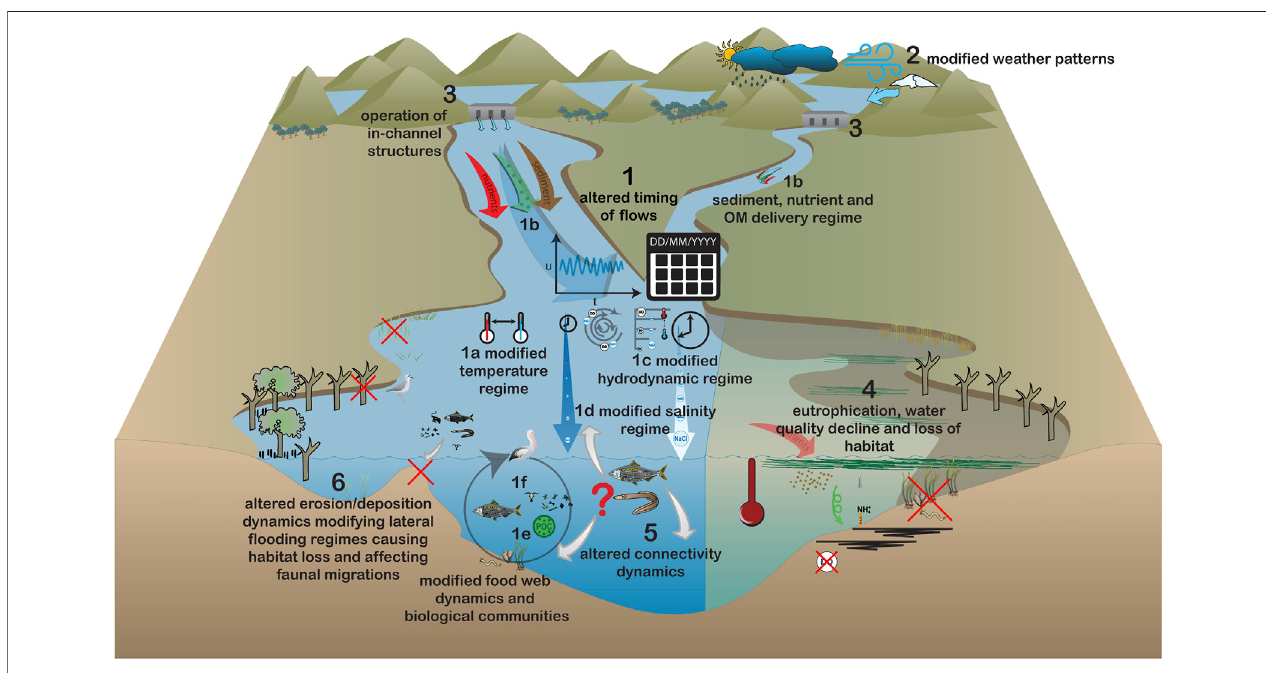
FIGURE 4 | Modi fi ed estuarine ecosystem processes under alterations to the timing of fl ows. Impacts of this fl ow scenario are: 1a – f) effects of modi fi ed seasonal fl ow patterns on a) water temperature, b) sediment, nutrient and organic matter inputs, c) hydrodynamics, d) salinity, e) food webs and f) biological community composition. This can cause 4) increased nutrient availability, phytoplankton blooms and eutrophication, 5) altered connectivity dynamics affecting migratory patterns and biological community functioning, and 6) altered mouth scouring and associated impacts upon migration of organisms, salinity and intertidal fl ooding regimes. Principal drivers are: 2) modi fi ed weather patterns as a result of climate change and 3) the presence and operation of in-channel